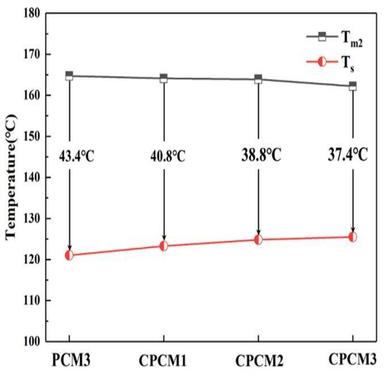
Degree of supercooling of PCM3 and CPCMs.